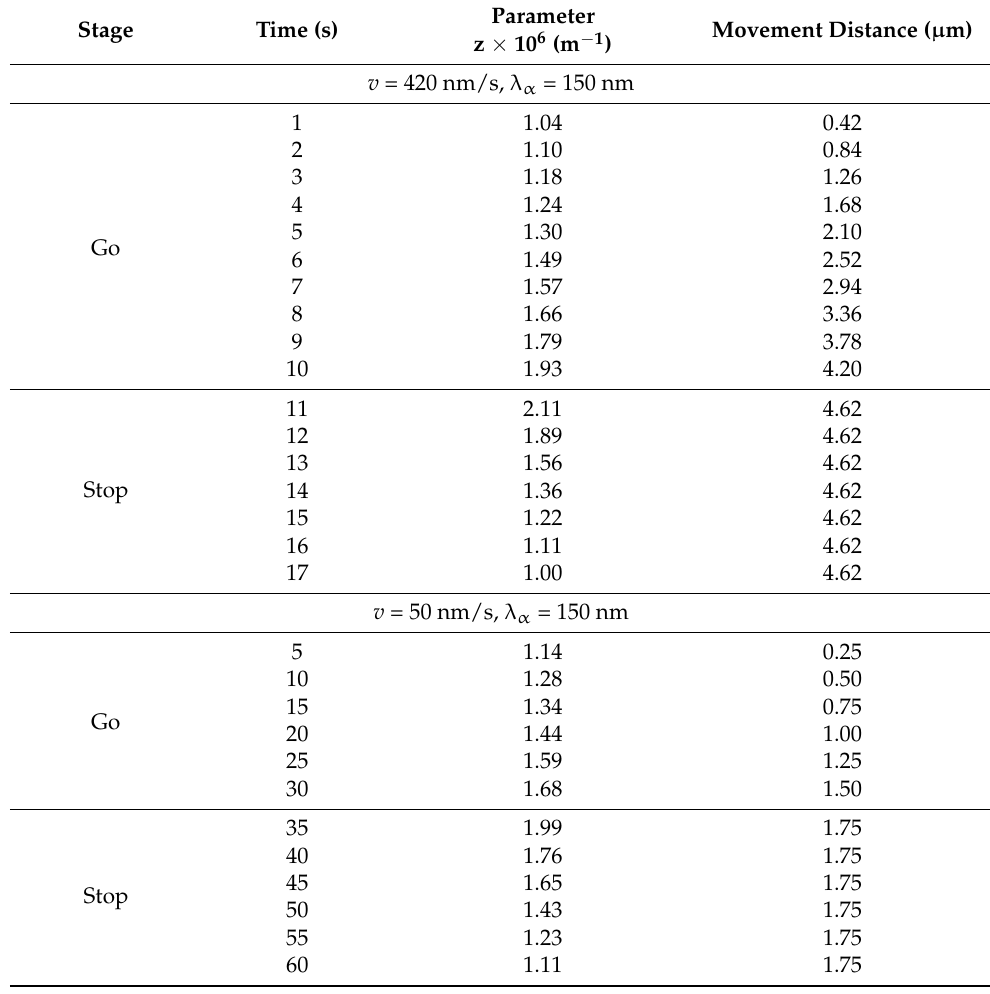
Table 3. Results of the simulation for λ α = 150 nm, x* = 16 at.% Zn and various values of v DD . Stage Time